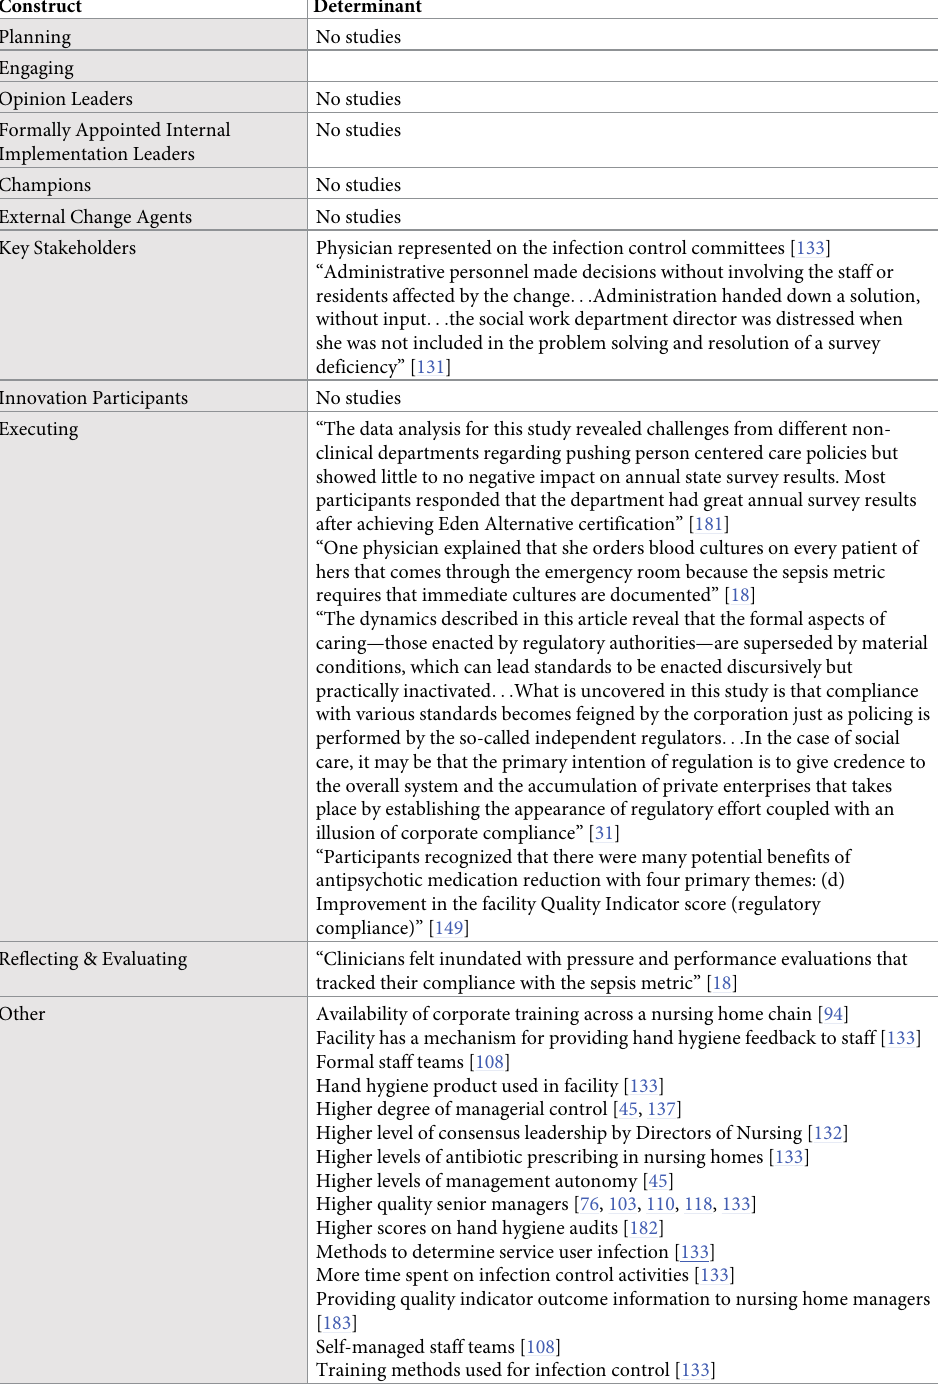
Table 6. Determinants coded to the process